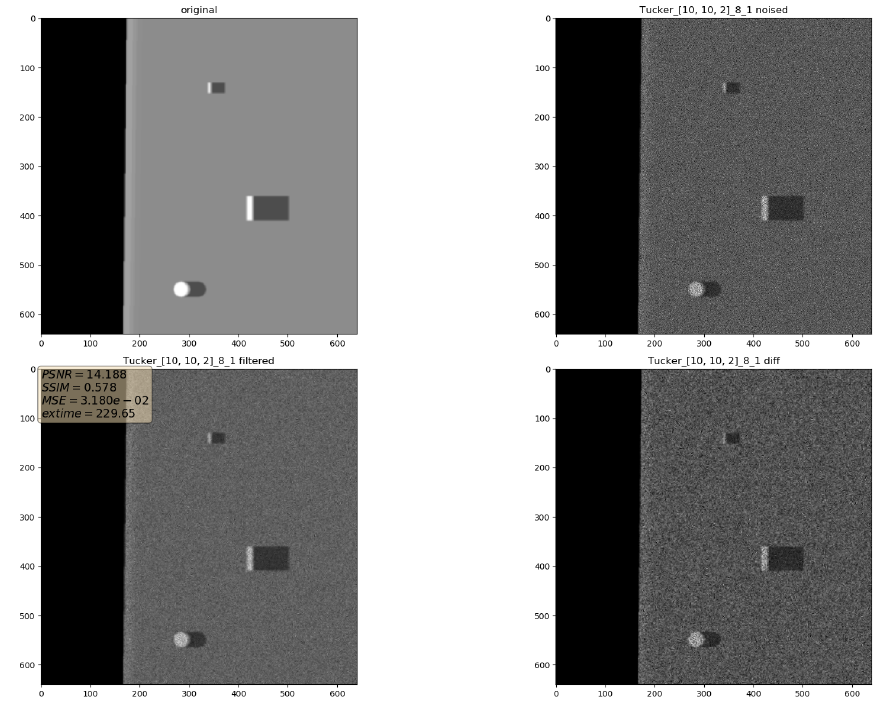
Figure 6. Filtering results for parameters: Tucker rank = [10, 10, 2], window size = 8, close neighbor distance = 1. Speckle noise σ 2 = 0.05.